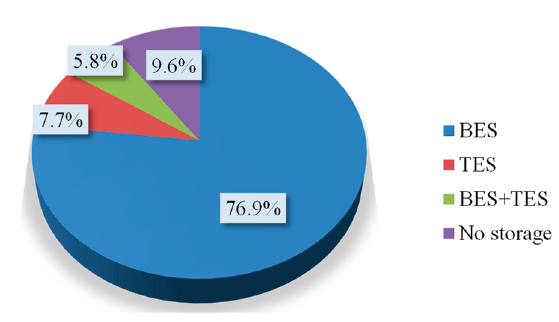
Figure 6. Distribution of energy storage technologies used in the projects.